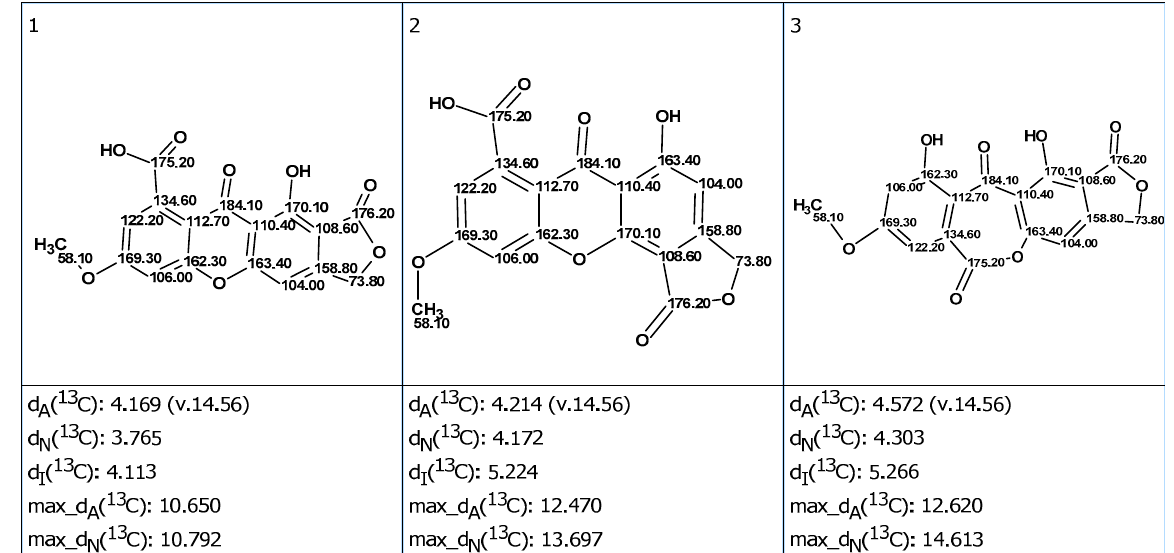
Figure 5. Three top-ranked candidate structures (1, 2 and 3) listed in order of increasing spectroscopic discrepancies. Average deviations are reported according to the prediction method—d A , HOSE-code; d N , neural network; and d I , incremental approach—along with the maximal 13 C NMR chemical shift deviation for each prediction method.